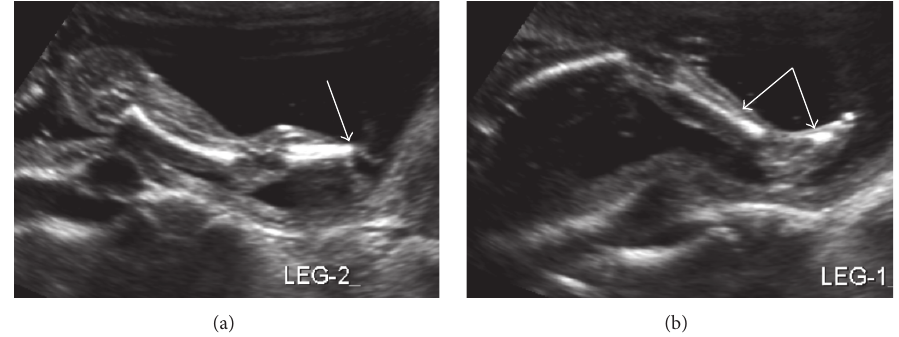
Figure 5: Official ultrasound on 1/13/2016: one lower extremity (left leg, leg 2 in (a)) is incomplete, the tibia fibula terminates abruptly and a foot is not seen. The other lower extremity (right leg, leg 1 in (b)) shows appropriate length for femur, tibia fibula, and a well formed foot. Noted during the examination are floating bands strongly suggestive of amniotic